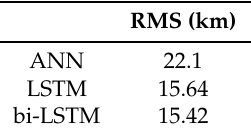
Figure 12. Bias of the ANN, LSTM and bi-LSTM models’ residuals at 12 different ionosonde stations. Blue, red and green lines denote the bias from the three models respectively. Table 2. RMS of different Australian regional models.